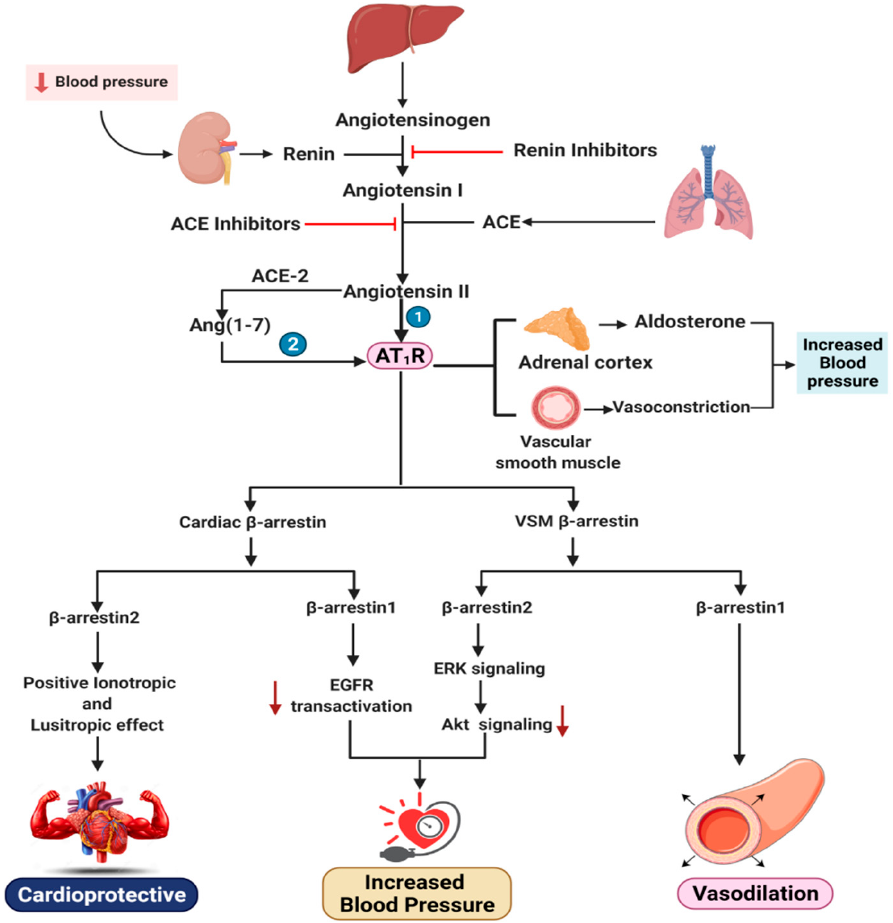
Figure 2. The renin–angiotensin–aldosterone system is a key regulator of blood pressure. Renin cleaves angiotensinogen into angiotensin I, which is further cleaved by ACE inhibitors to form angiotensin II. Here, two distinct pathways are possible. ( A ) Angiotensin II activates the AT 1 R and elicits vasoconstriction or aldosterone secretion, which eventually raises blood pressure. (B) Angiotensin II is cleaved by ACE2 or other carboxypeptidases to generate the heptapeptide Ang-(1–7), which is also responsible for β -arrestin1 and β -arrestin2 recruitment, giving both detrimental and salutary effects in terms of the cardiovascular system and